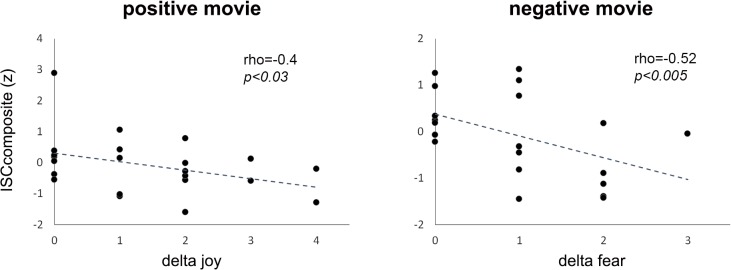
Association of autonomic synchronization and emotional convergence.Correlation between the extent of autonomic synchronization, as indexed by ISCcomposite scores, and the degree of emotional convergence (small delta scores signify higher convergence). Results are shown separately for positive and negative emotional movies.